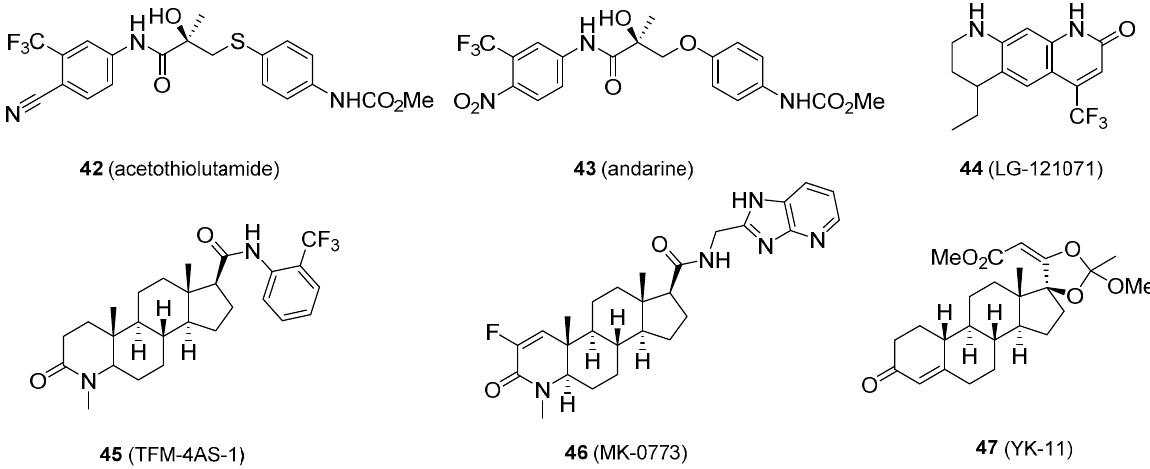
Figure 8. Selective androgen receptors modulators that have been eliminated from further re- search.